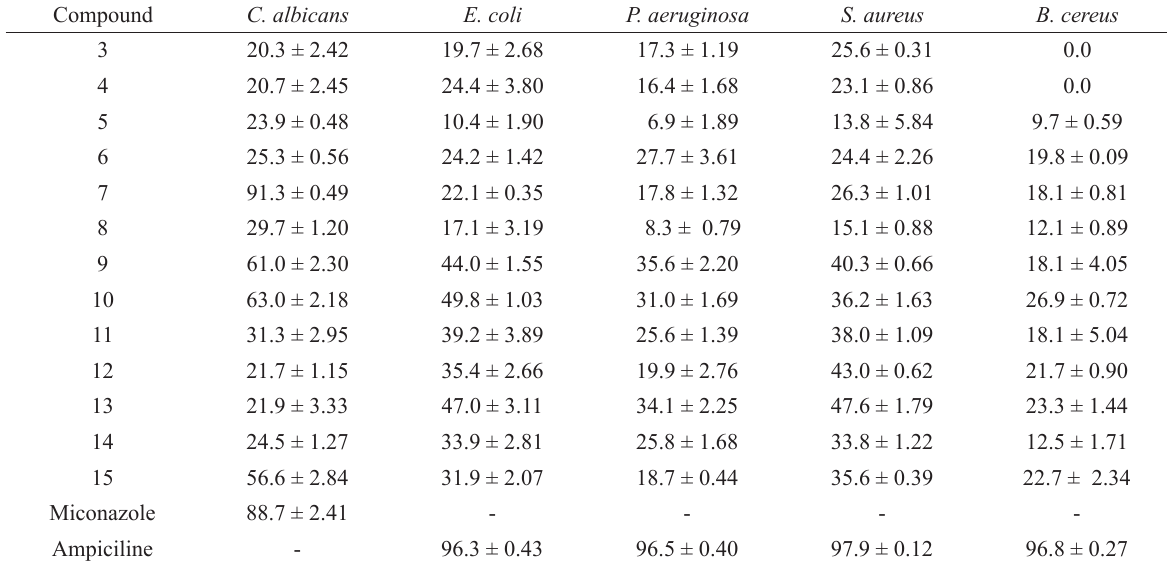
Antifungal and antibacterial activity data of hydroxyl amides 3-15, at 250 mg/mL.